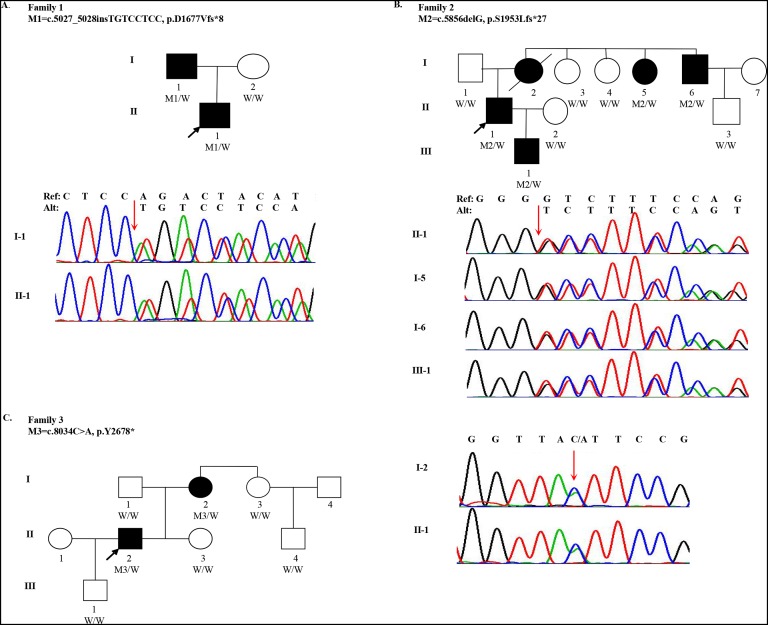
Pedigree and mutations in FBN1 for Marfan syndrome patients.(A) A FBN1 insertion mutation (M1) was identified in two subjects with MFS (I-1 and II-1) from Family 1; (B) A FBN1 deletion mutation (M2) was identified in four subjects with MFS (I-5, I-6, II-1 and III-1) from Family 2; (C) A FBN1 nonsense mutation (M3) was identified in two subjects with MFS (I-2 and II-2) from Family 3. Three individuals in the pedigrees were not sequenced including Family 2: I-2, I-7 and Family 3: I-4. W indicates wildtype allele. Circles represent female participants and squares male participants. Black symbols indicate patients with Marfan syndrome. A slash through the symbol indicates that the family member is deceased. Arrows indicate the proband.